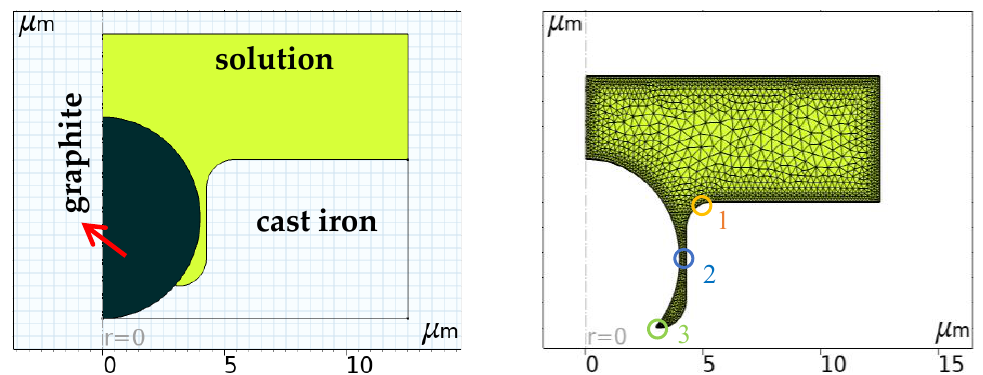
in the later simulation studies.